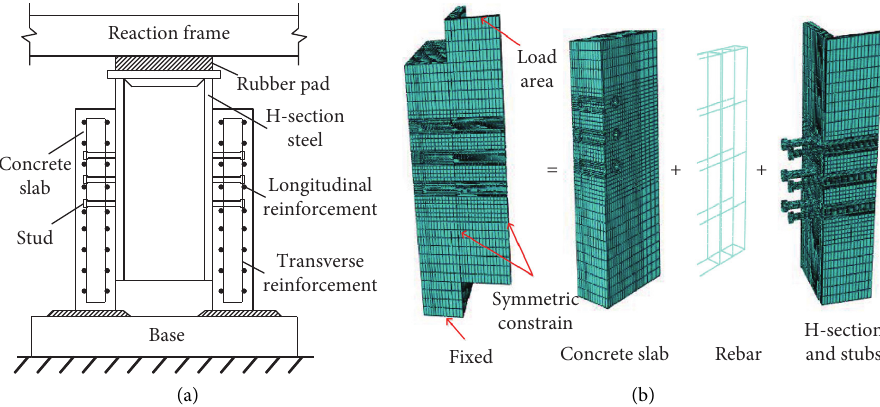
Figure 6: Schematic of shear studs: (a) test model; (b) numerical model.